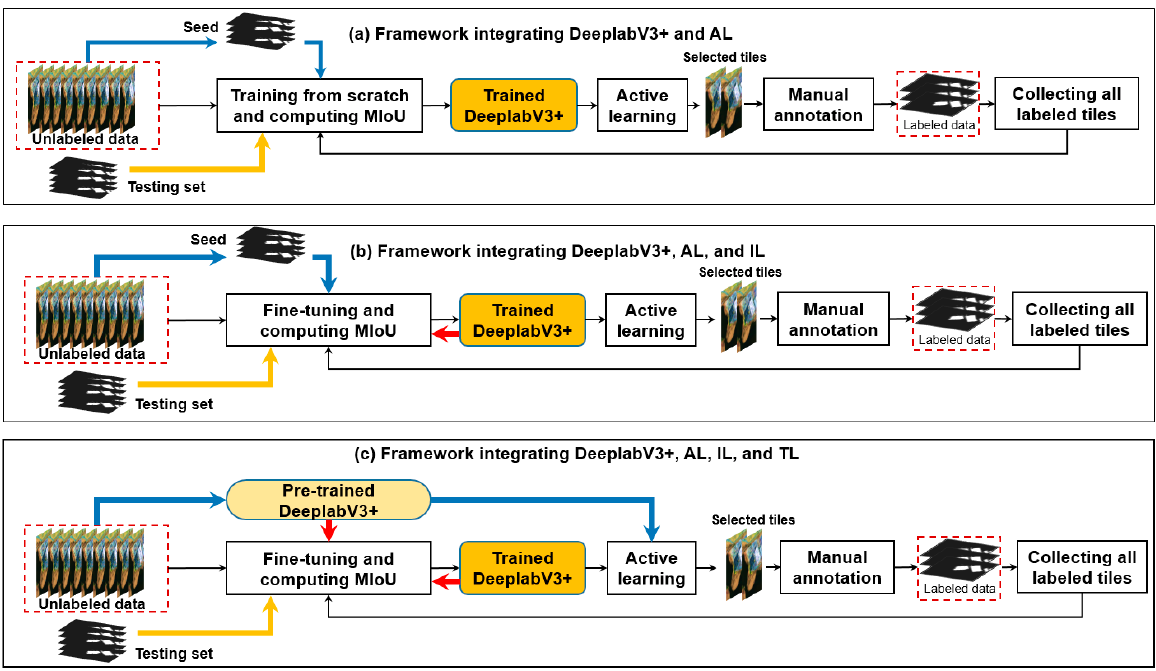
Figure 2. Three candidate frameworks for building footprint mapping by incorporating the DeeplabV3+ model, AL, IL, and TL. In each framework, the blue arrows indicate the steps in the first iteration; the orange arrow shows the data flow for model evaluation; and the black arrows indicate the data selection, data annotation, updating labeled dataset, and model re-training per iteration from the second iteration. The red arrows indicate calling the previous model for fine-tuning. Framework ( a ) shows the basic process of incorporating DeeplabV3+ with AL. Framework ( b ) shows the process of incorporating DeeplabV3+ with AL and IL. Framework ( c ) shows the process of incorporating the DeeplabV3+ with AL strategies, IL, and